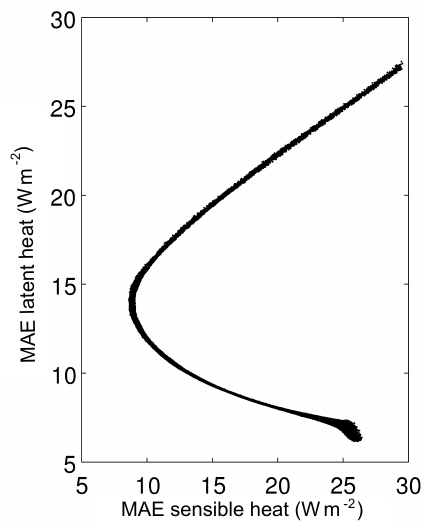
Figure 10. Latent vs. sensible heat (Wm − 2 ) for behavioral (well- performing) simulations. Each dot was the output from a random simulation. The mean absolute error was used to evaluate the model. Results were similar for the Nash–Sutcliffe